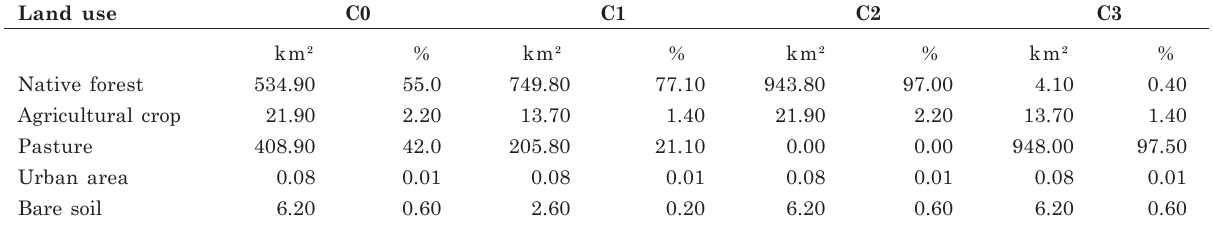
Table 2. Land use and soil cover in real and simulated scenarios by SWAT model in the Galo creek